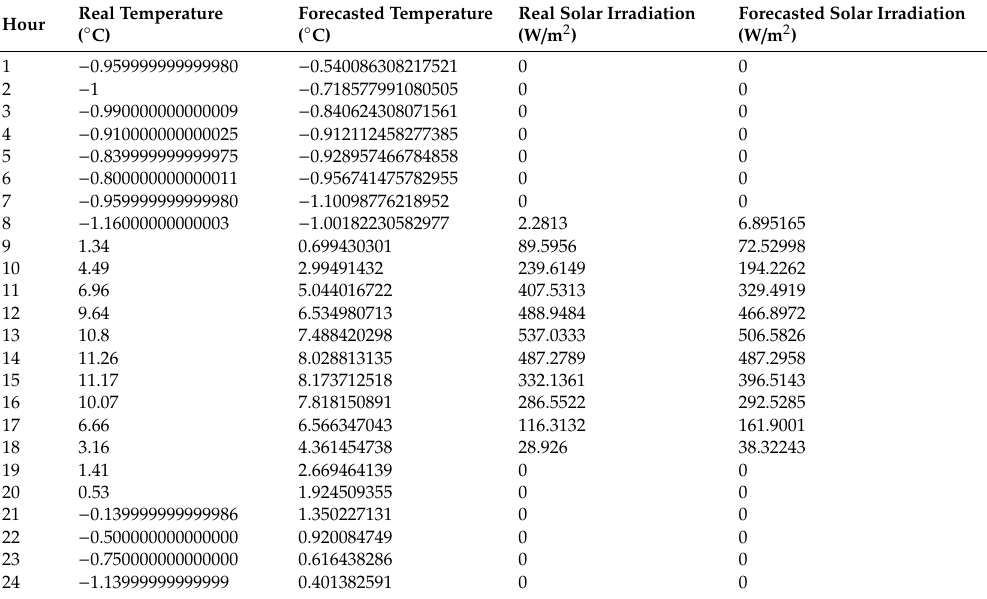
Table A2. Forecasting results and real data for temperature and solar irritation data for 04 / 02 / 2019.